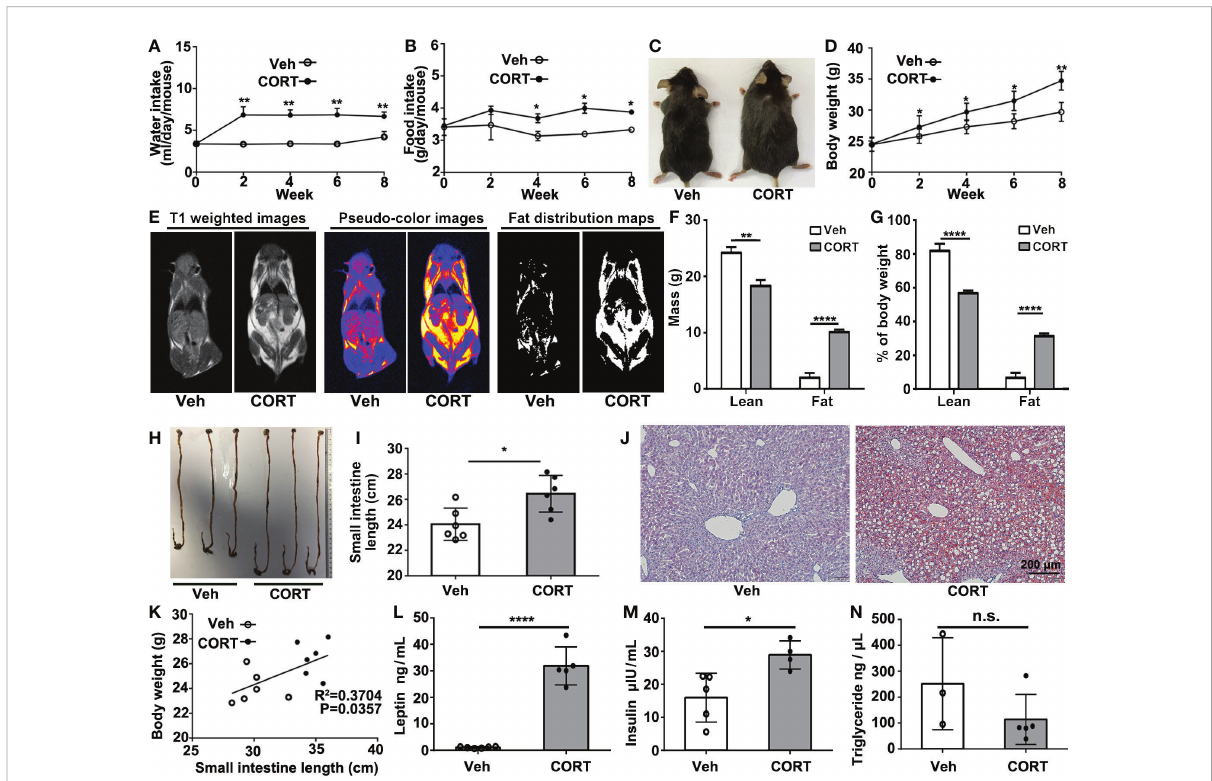
FIGURE 1 CORT induced obese phenotype, increased intestinal length, hepatic steatosis and changes in serum. (A) Water consumption and (B) food consumption of mice injected with CORT or Vehicle. (C) Representative images comparing the body size of a CORT-treated mouse with a vehicle- control mouse. (D) Body weight curves of mice treated with CORT or vehicle for 8 weeks. (E) Representative MRI images for body composition analysis. (F) Evaluation of fat mass. (G) Evaluation offat percentage. (H) The representative images of the intestines of the mice treated with CORT or vehicle. (I) Quanti fi cation of the length of the small intestines from the mice treated with CORT or vehicle. (J) Representative images of Oil red O staining of the liver sections. (K) Correlation analysis between body weight and small intestine length. (L) Detection of the concentrations of serum leptin, (M) insulin and (N) triglyceride for the two groups of mice. Data are expressed as mean ± SEM, *p < 0.05, **p < 0.01, ****p < 0.0001. Veh: vehicle-treated group; CORT, corticosterone-treated group; n.s., not signi fi